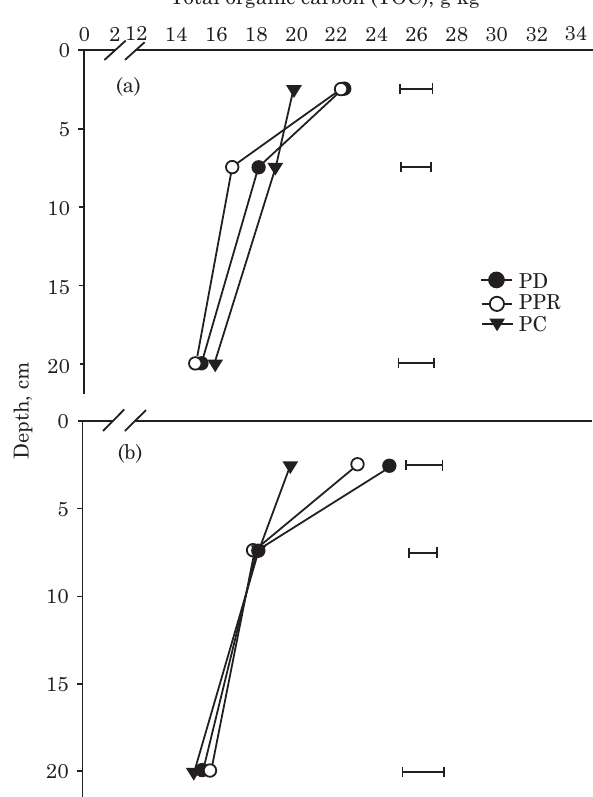
Figure 1. Total organic carbon (TOC) in Oxisol under different tillage systems, in summer (a) and winter sampling (b). NT, RT and CT are, respectively, no-tillage, reduced tillage and conventional tillage. The horizontal bars refer to the least significant difference (LSD) by the Tukey test